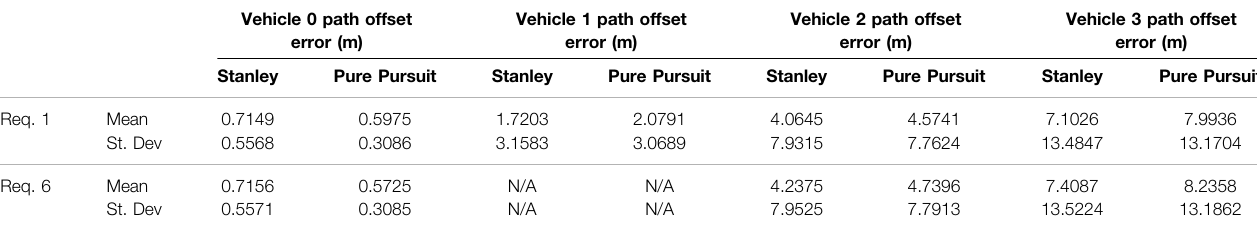
TABLE 3 | Comparison metrics for path offset